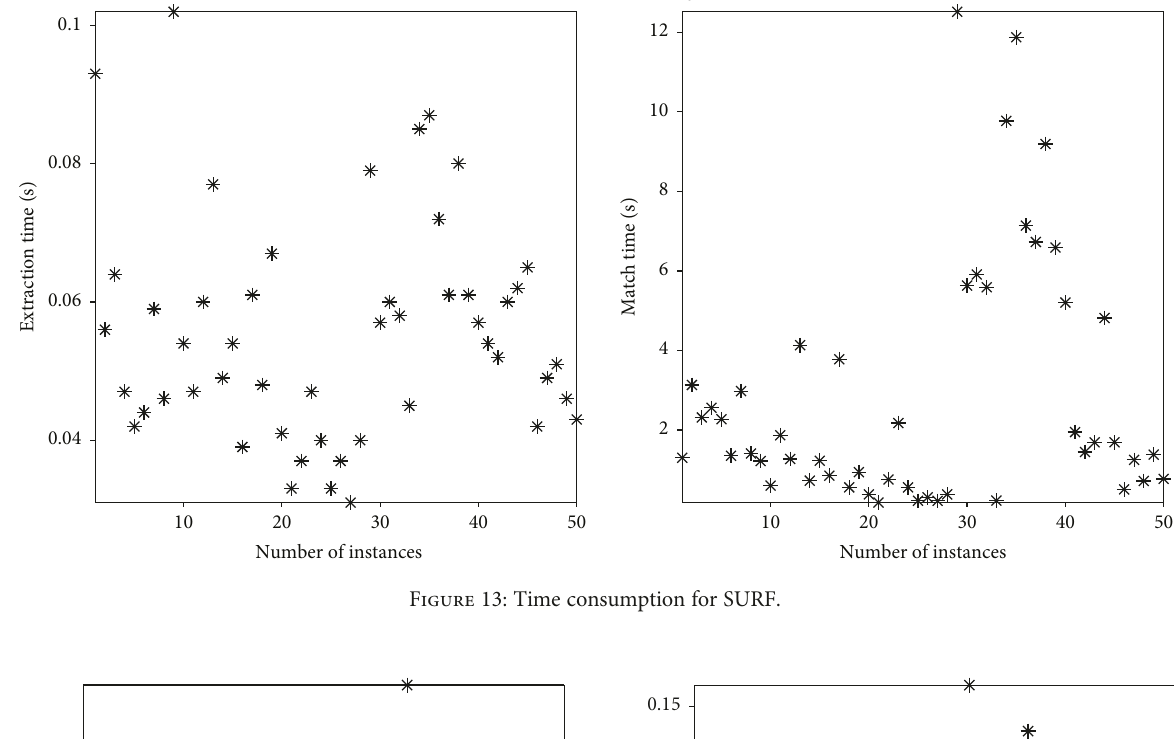
Figure 13: Time consumption for SURF.